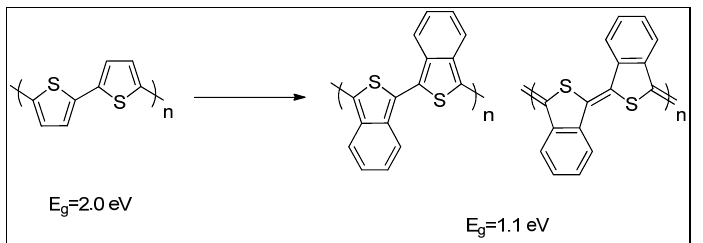
Figure 18. The molecular structure of incorporating a fused ring in the thiophene system.